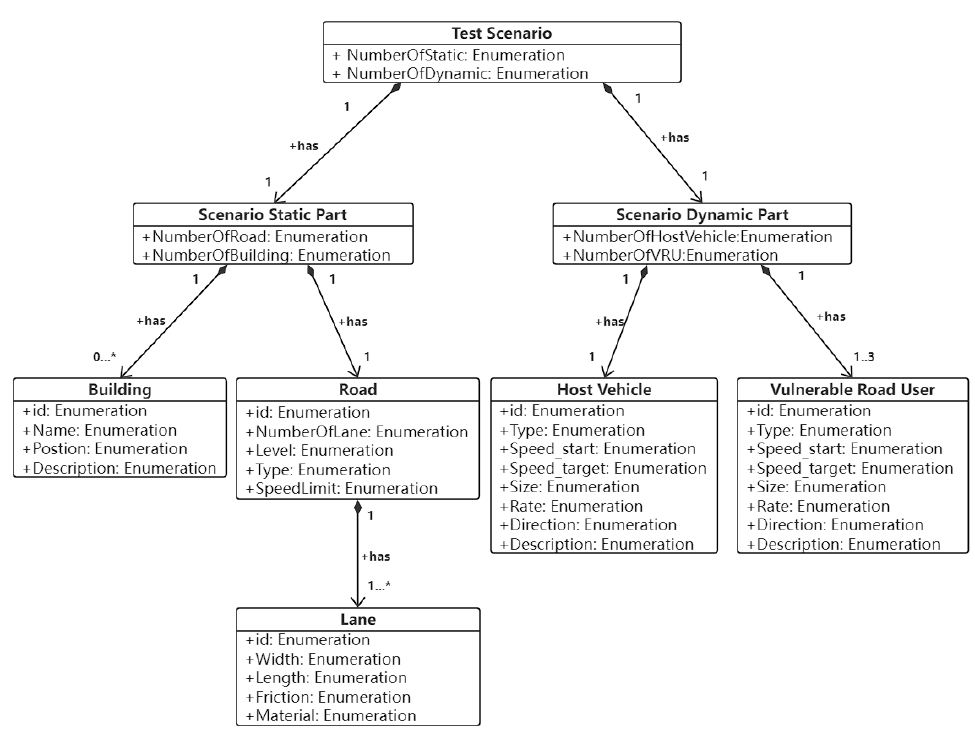
Figure 13. Constructed VRUCW ontology using Unified Modeling Language